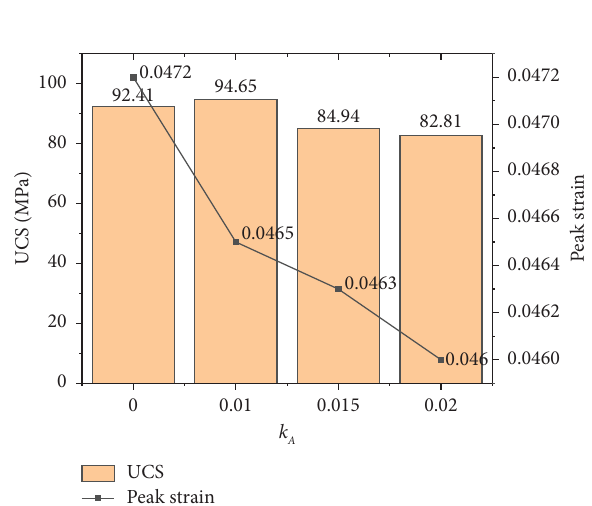
Figure 21: Elastic modulus and Poisson’s ratio of stones with CE of 0.25 diferent k CE